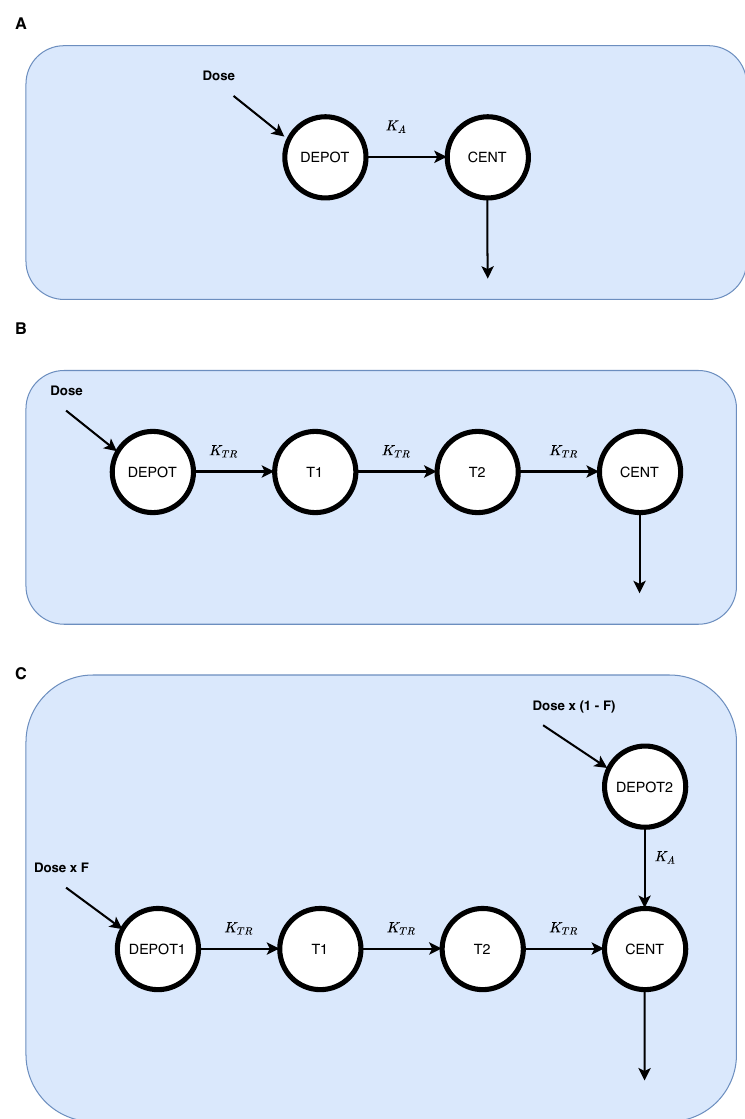
Figure 2. Pharmacokinetic structural models of the three absorption profiles. ( A ) First-order absorp- tion; ( B ) Erlang absorption process; ( C ) Mixed first-order and Erlang